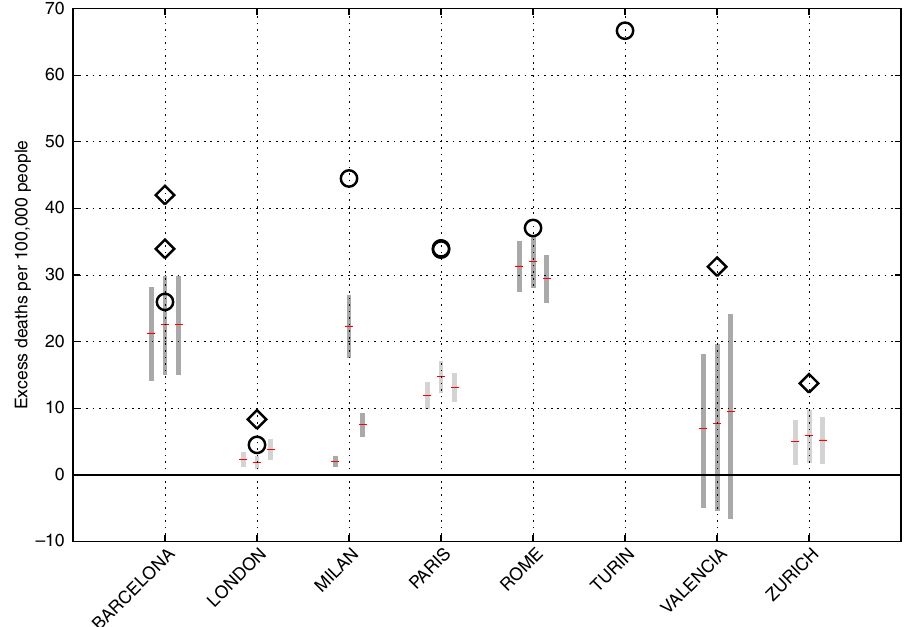
Fig. 6 City-speci fi c estimates of the excess mortality attributable to the 2003 EHWD. Black symbols are observed estimates from the literature (Supplementary Table 3; note two very similar estimates for Paris). Circles denote studies that have reported both the number of excess deaths and the baseline population; diamonds denote studies which have only reported the number of excess deaths and where we have used the corresponding city population reported for 2003 in of fi cial statistics as a baseline. Grey bars and red lines are results from this study, for three different climate forcing datasets (left: GSWP3, middle: PGFv2, right: WFDEI). The bars indicate the results obtained by using the lower and upper 95% con fi dence intervals for the linear exposure response function slopes from ref. 60 , and the red line indicates the result obtained using the central estimate for the